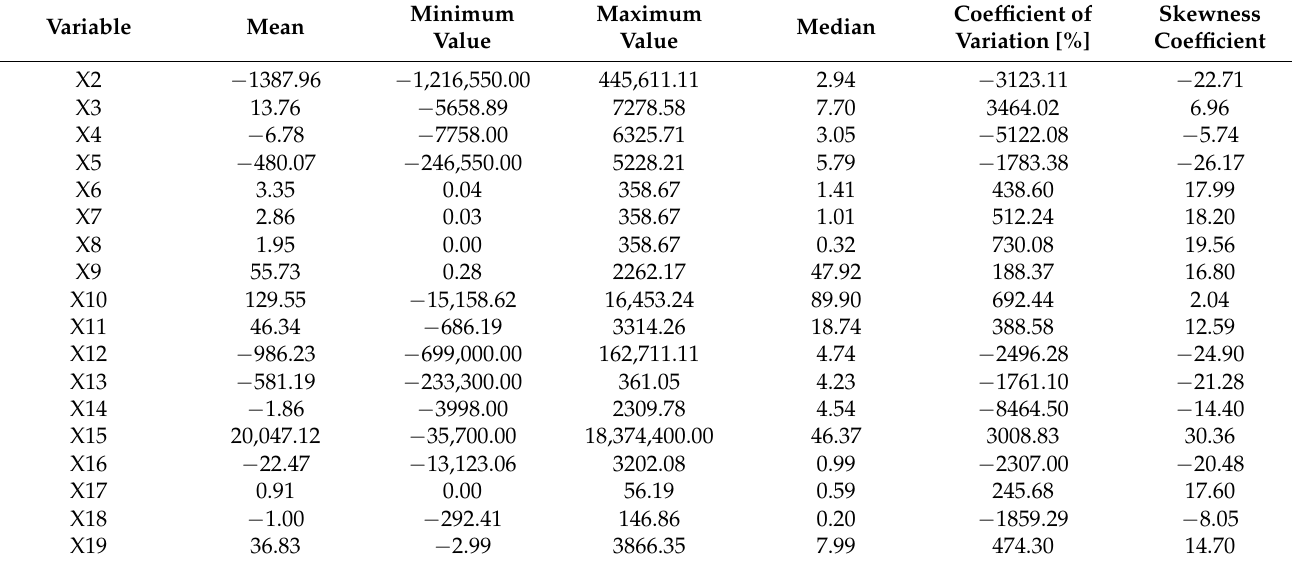
Table 5. Values of basic statistics for continuous independent variables.